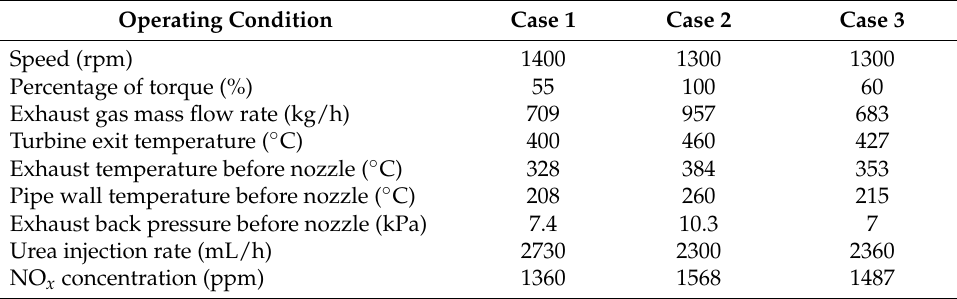
Table 2. Test data under each typical operating